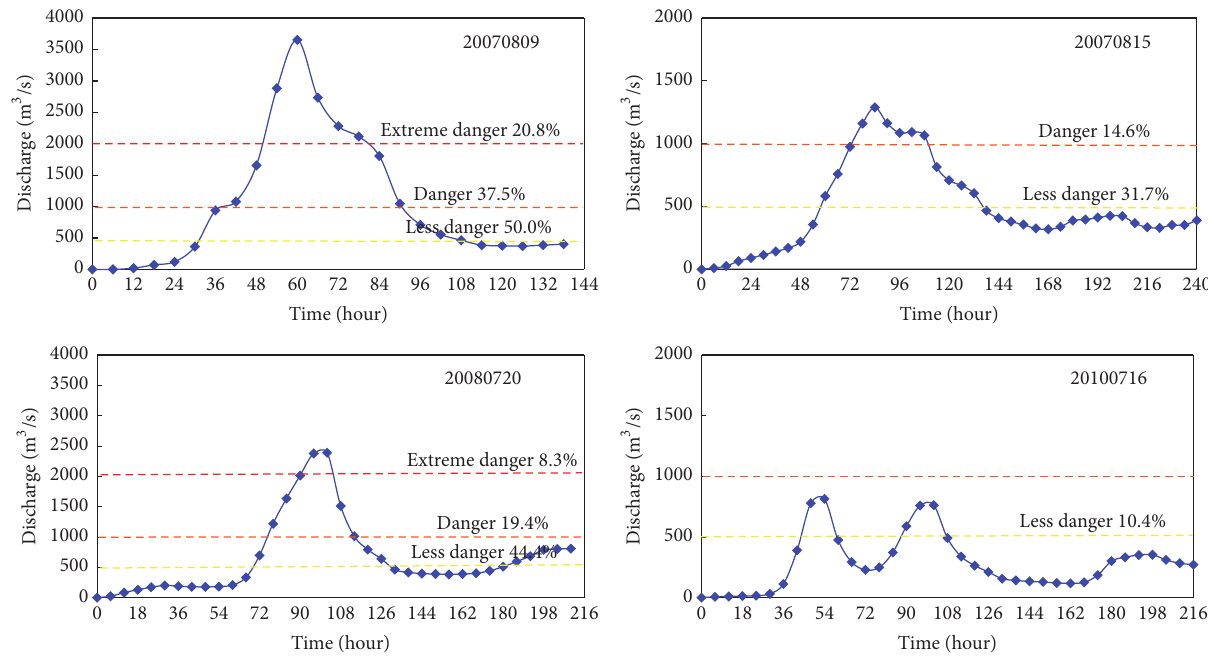
Figure 6: Flood warning probability from superensemble